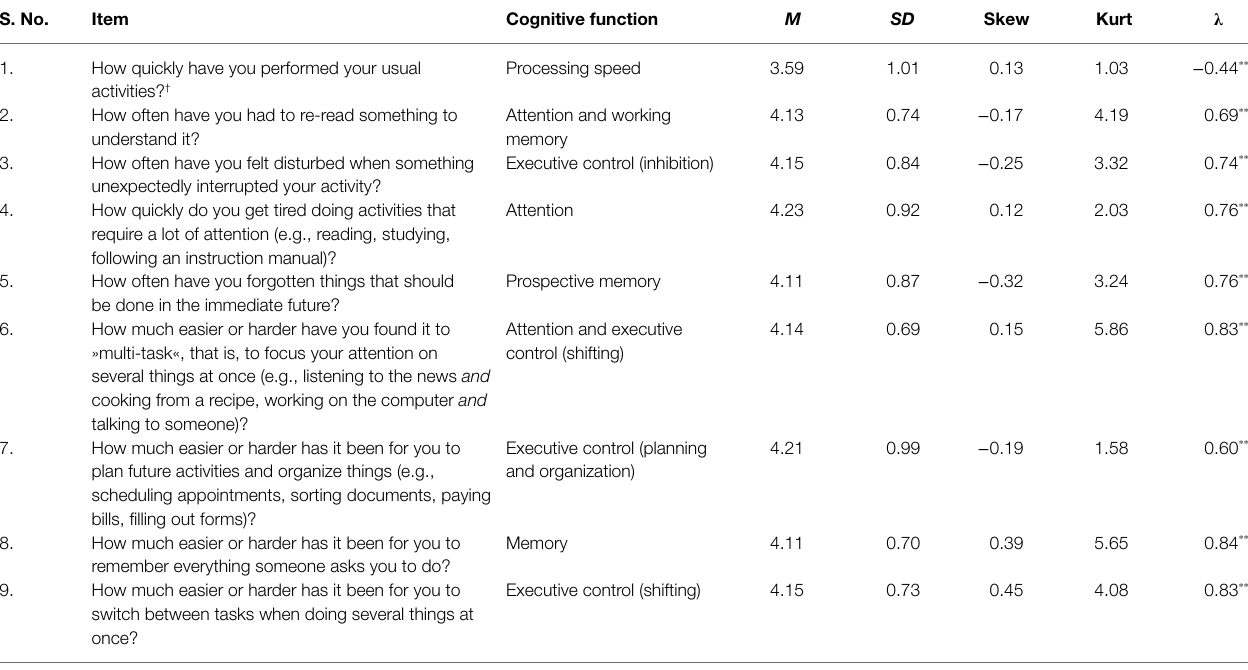
TABLE 2 | Item content, descriptive statistics, and standardized factor loadings from the one-factor measurement model of the CCQ. S.